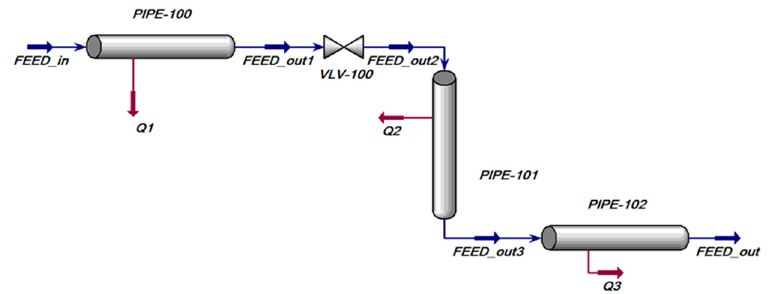
Figure 2. Simulation environment.